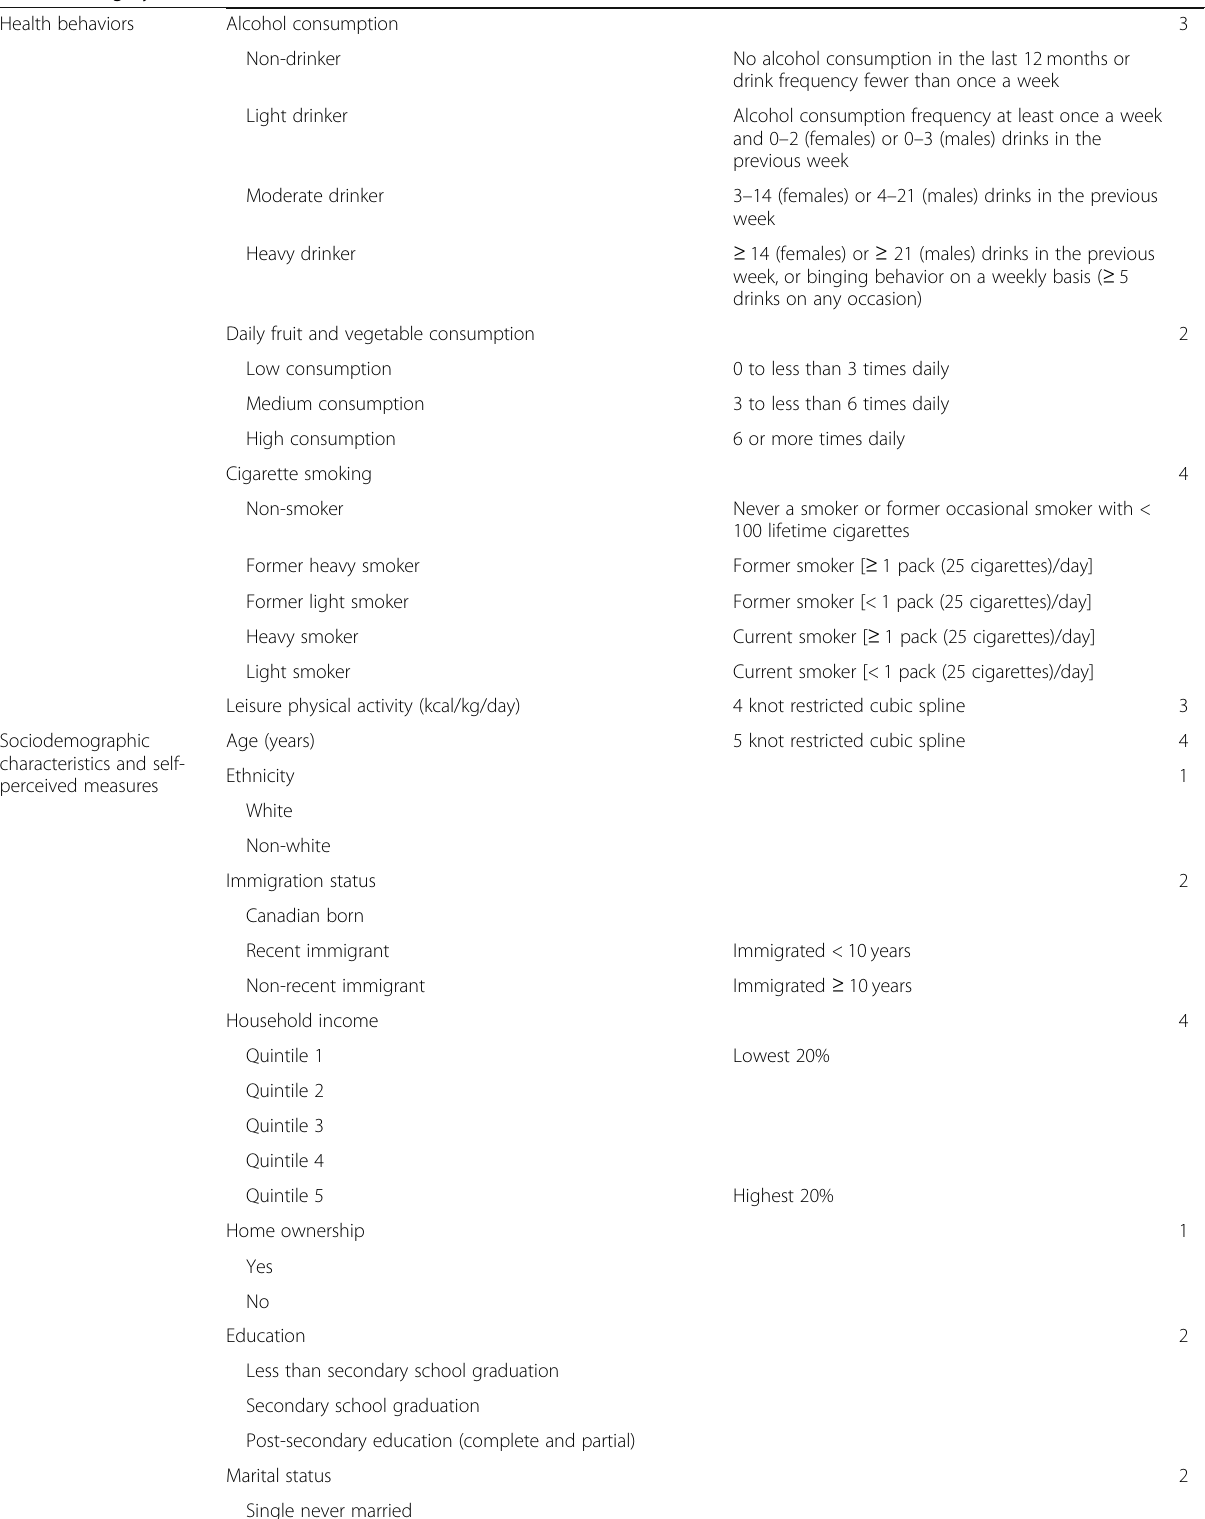
Table 1 Pre-specification of PreMPoRT predictive variables Variable